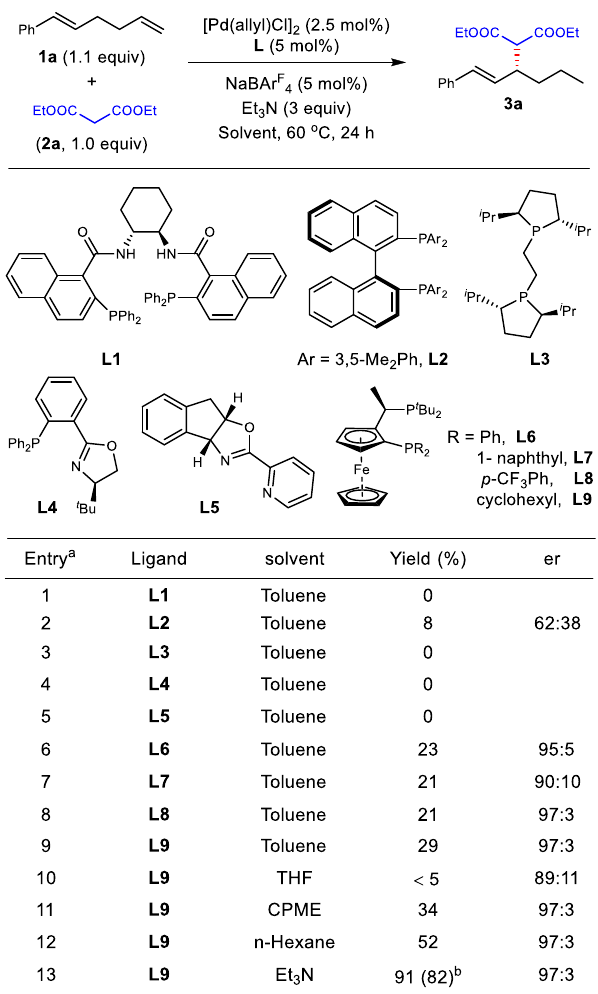
Fig. 2 Evaluation of reaction conditions for the migratory allylic substitution. a The reactions were run with 2a (0.2 mmol), NaBAr F 4 (Ar F = 3,5-(CF 3 ) 2 Ph, 5 mol%) in solvent (0.2 mL). Yields were determined by crude 1 H NMR. Er values were determined by chiral HPLC. THF, tetrahydrofuran. CPME, cyclopentyl methyl ether. b Isolated